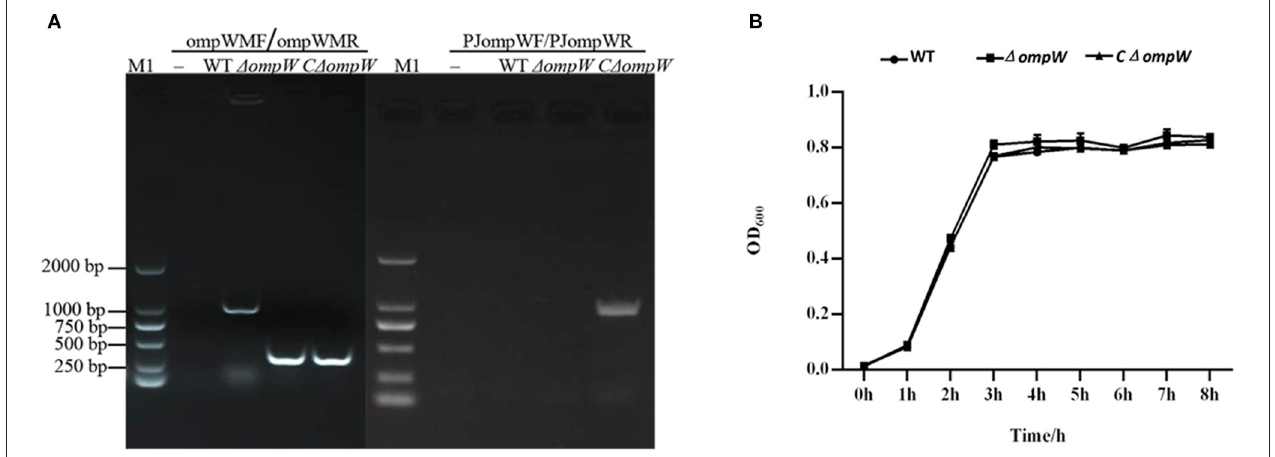
FIGURE 1 | (A) Confirmation of the 1 ompW mutant and C 1 ompW by PCR using primer pairs. M1: 2000 bp marker; WT: wild type strain of A. pleuropneumoniae . (B) Growth curves for the A. pleuropneumoniae strain, the 1 ompW mutant strain, and the C 1 ompW strain, cultured to logarithmic growth phase. The OD 600 values of bacterial solutions are presented.